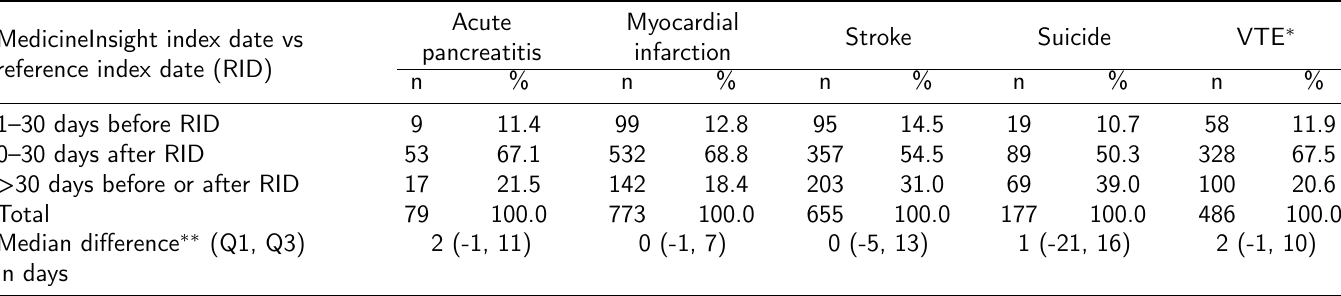
Table 3: Time between recording of acute serious events in EHR (MedicineInsight) and linked (Reference) data for ‘true positive’ cases during